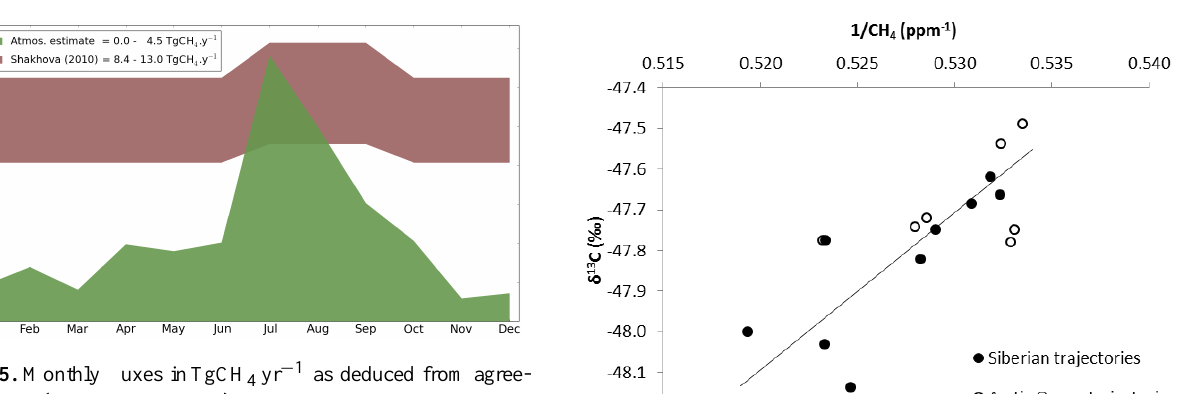
Figure 5. Monthly fluxes inTgCH 4 yr − 1 as deduced from agree- ment scores (green; see Sect. 2.4) computed for every month of the year 2012, compared to Shakhova et al. (2010) fluxes (brown).